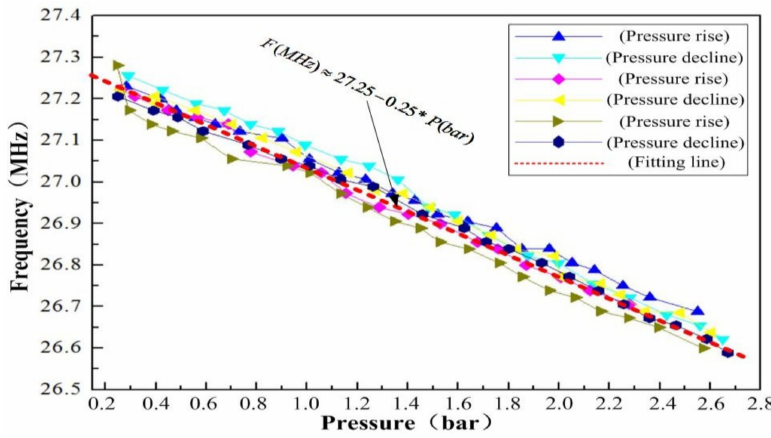
Figure 8. Resonant frequency of the sensor as a function of the pressure at 900 ◦